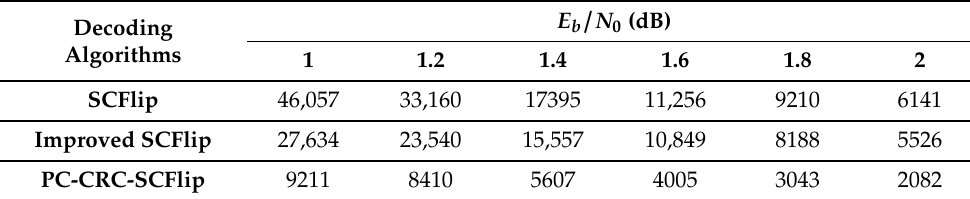
Table 2. Decoding clock cycle comparison of the proposed PC-CRC-SCFlip decoder with SCFlip and the improved SCFlip for P ( 1024,512 ) with 24 check bits.